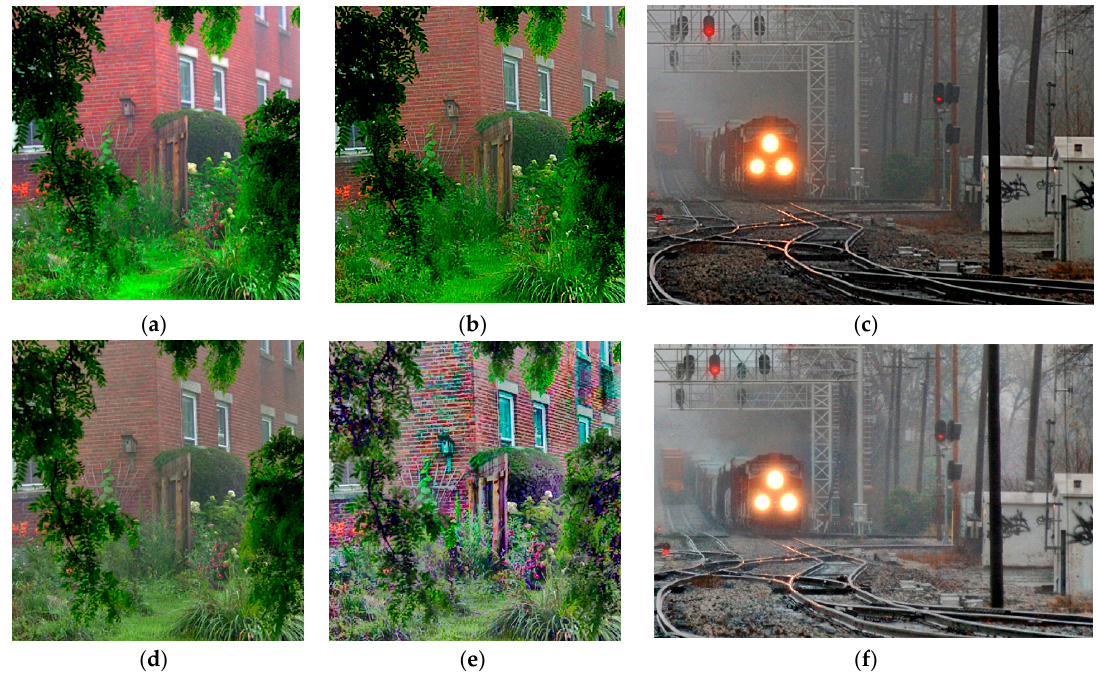
Figure 7. ( a ) PA (high-boost) ( b , c ) PA ( d ) AMEF (c = 0.03) ( e , f ) AMEF ( c = 0.1). J. Imaging 2018 , 4 , x FOR PEER REVIEW